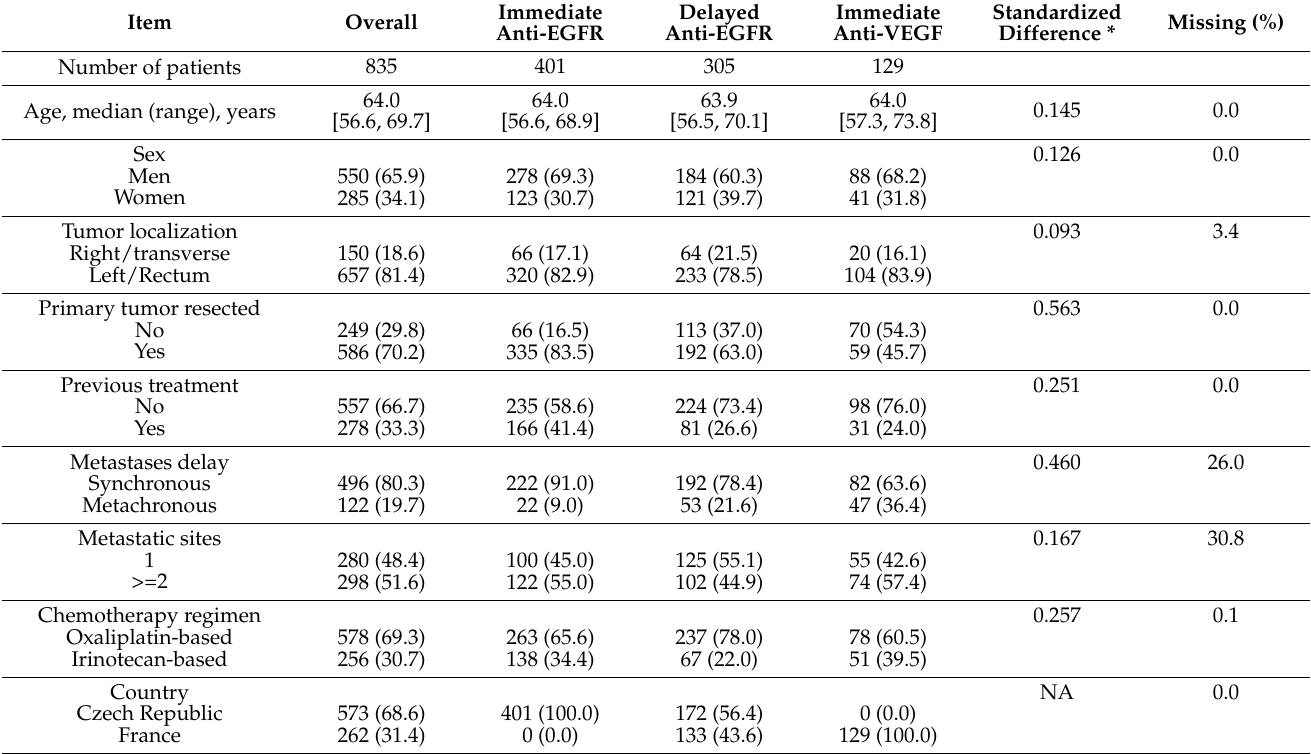
Table 1. Baseline characteristics in the unweighted study population.